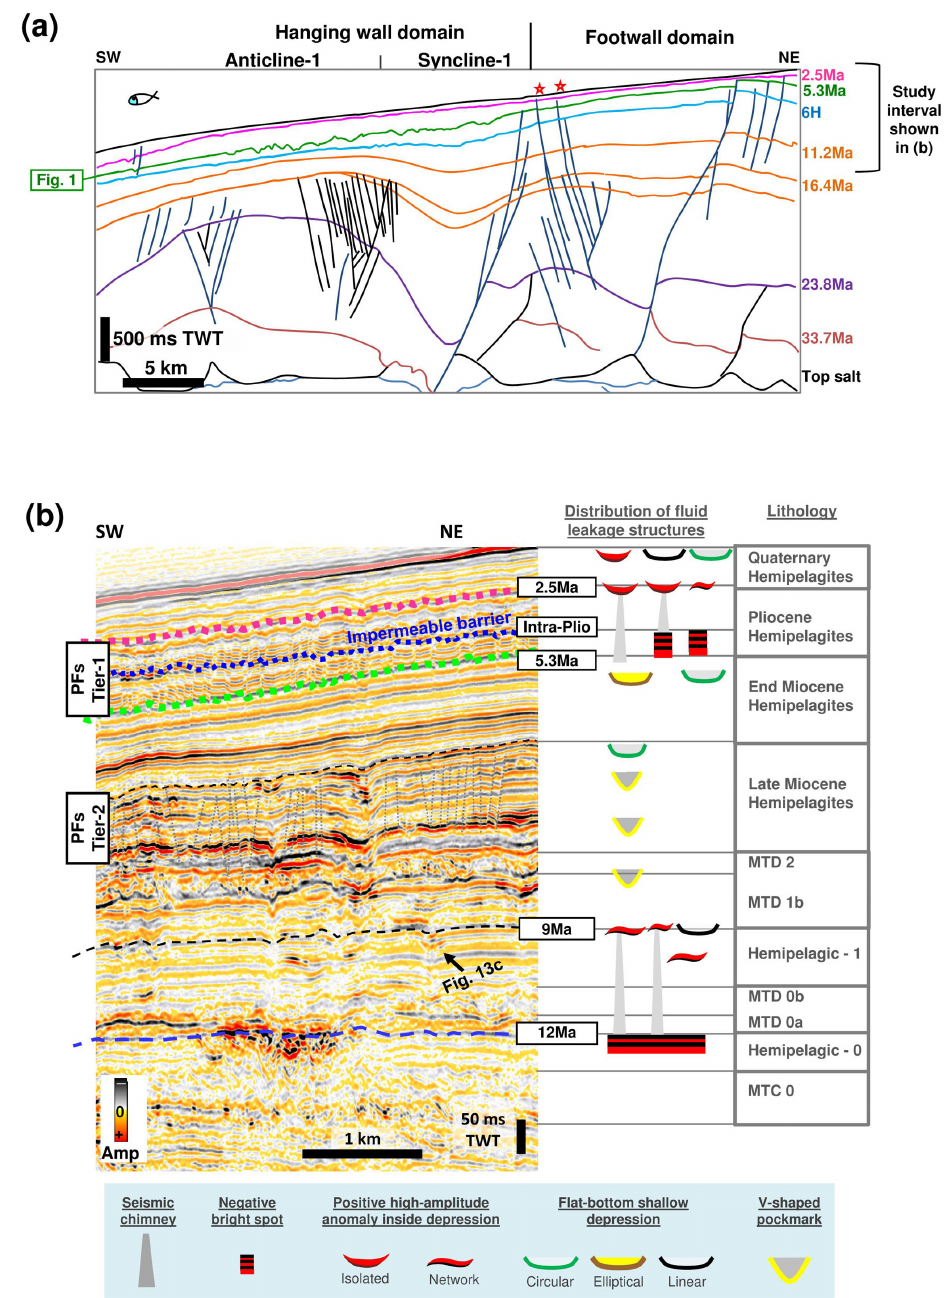
Figure 2. Geological setting. (a) Interpreted cross section through the study area. See Fig. 1 for location. Red stars indicate faults that were reactivated during the Quaternary. (b) Types of fluid expulsion structures and their distributions within the stratigraphic framework are shown to the right of seismic section. Horizons prefixed “H” and their approximate ages are shown. Figure adapted from Ho et al. (2012a) and Ho